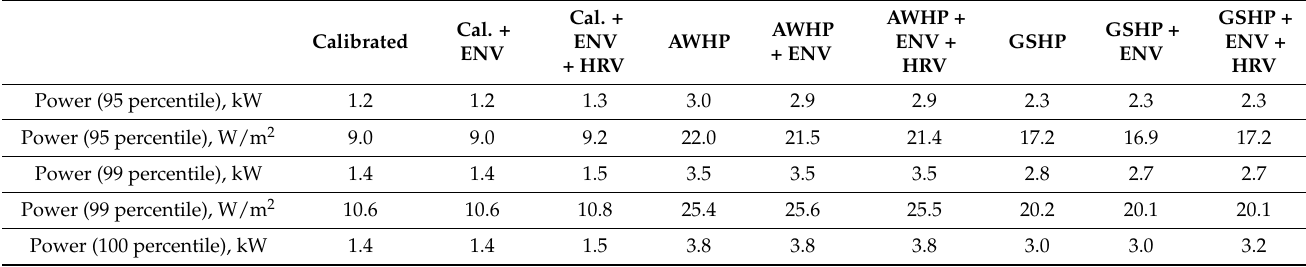
Table 3. Electric power at percentile value for different renovation